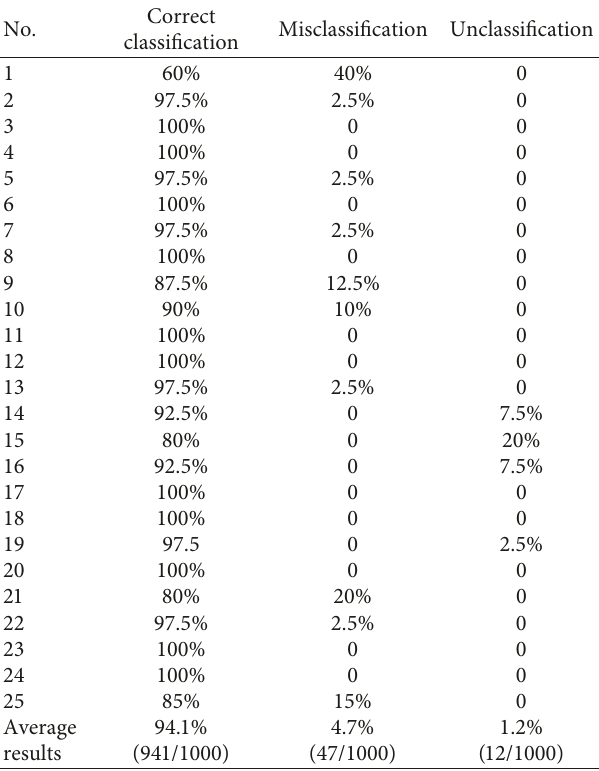
Figure 5: Estimated root mean square error of cross validation using SIMCA according to the number of principal components for 25 validation Table 3: Classification performance using SIMCA with PCA for 25 geological samples.